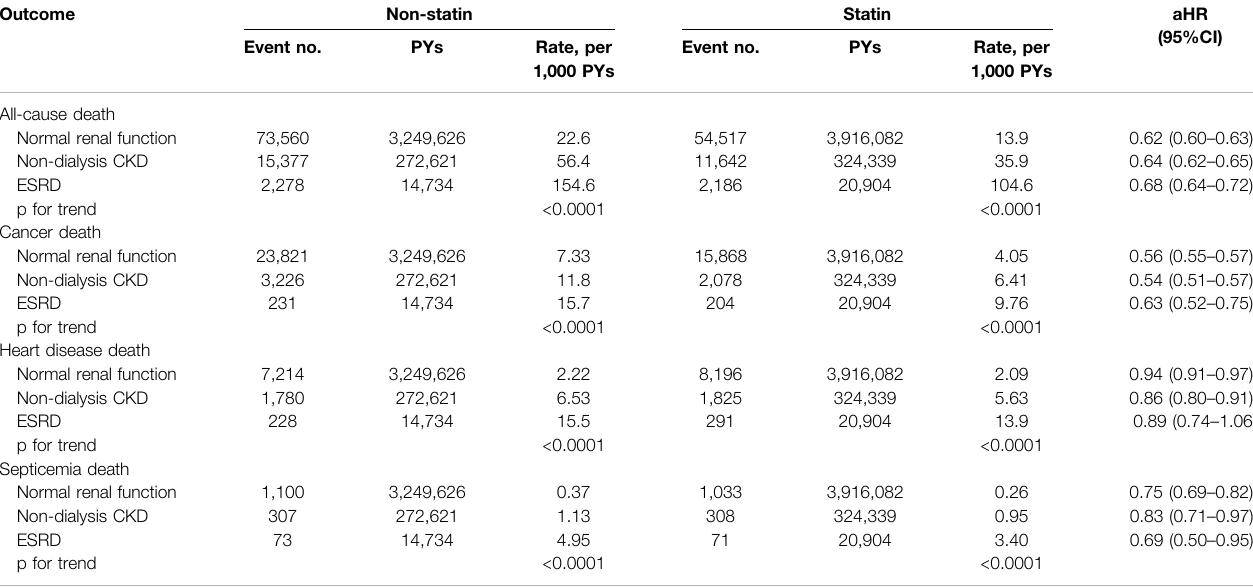
TABLE 2 | Mortality compared between statin users and non-users by cause and renal group.